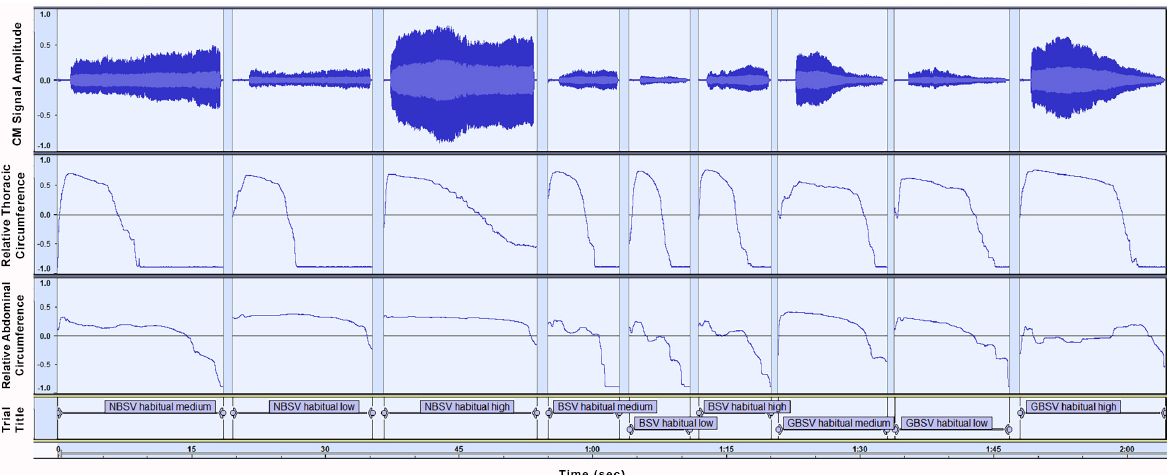
Figure 9. Graph of the nine initial trials for Participant 1 (P1). Sensors depicted are Microphone (top graph), Thoracic circumference Respiratory Effort Transducer (RETt) (middle graph), Abdominal circumference Respiratory Effort Transducer (RETta) (bottom graph). Individual trial labels correspond to trial conditions, namely ( left to right ) (1) breathiness degree: Non-Breathy singing Voice (NBSV), Breathy singing Voice (BSV), and ‘Gradual’ Breathiness singing Voice (GBSV), (2) frequency: ‘habitual’ refers to participant habitual voice frequency, (3) vocal intensity: medium, low, high.